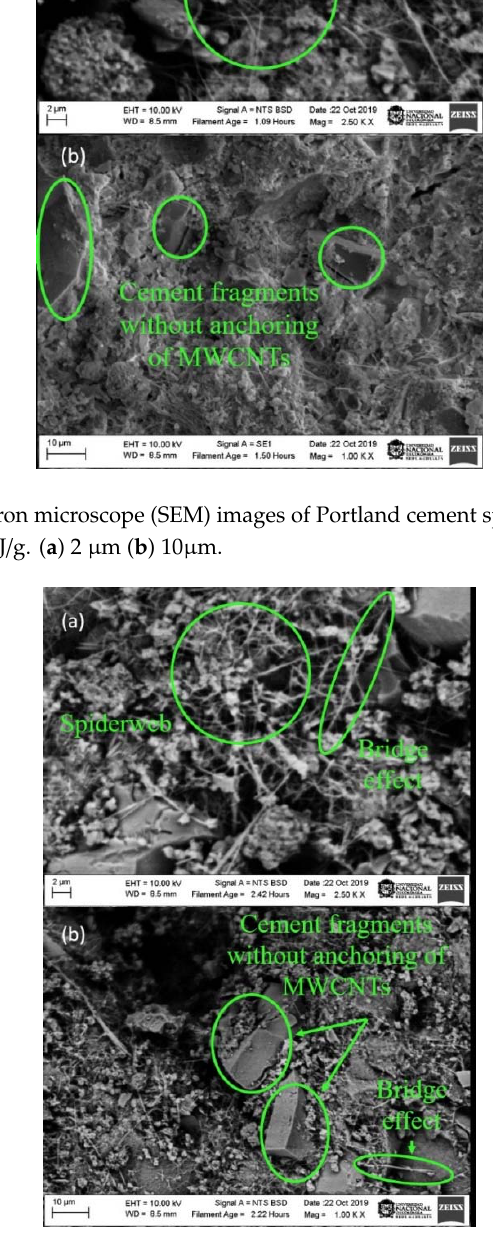
Figure 9. SEM images of Portland cement specimens with a dispersion solution addition at 390 J/g. ( a ) 2 μ m ( b ) 10 μ m.